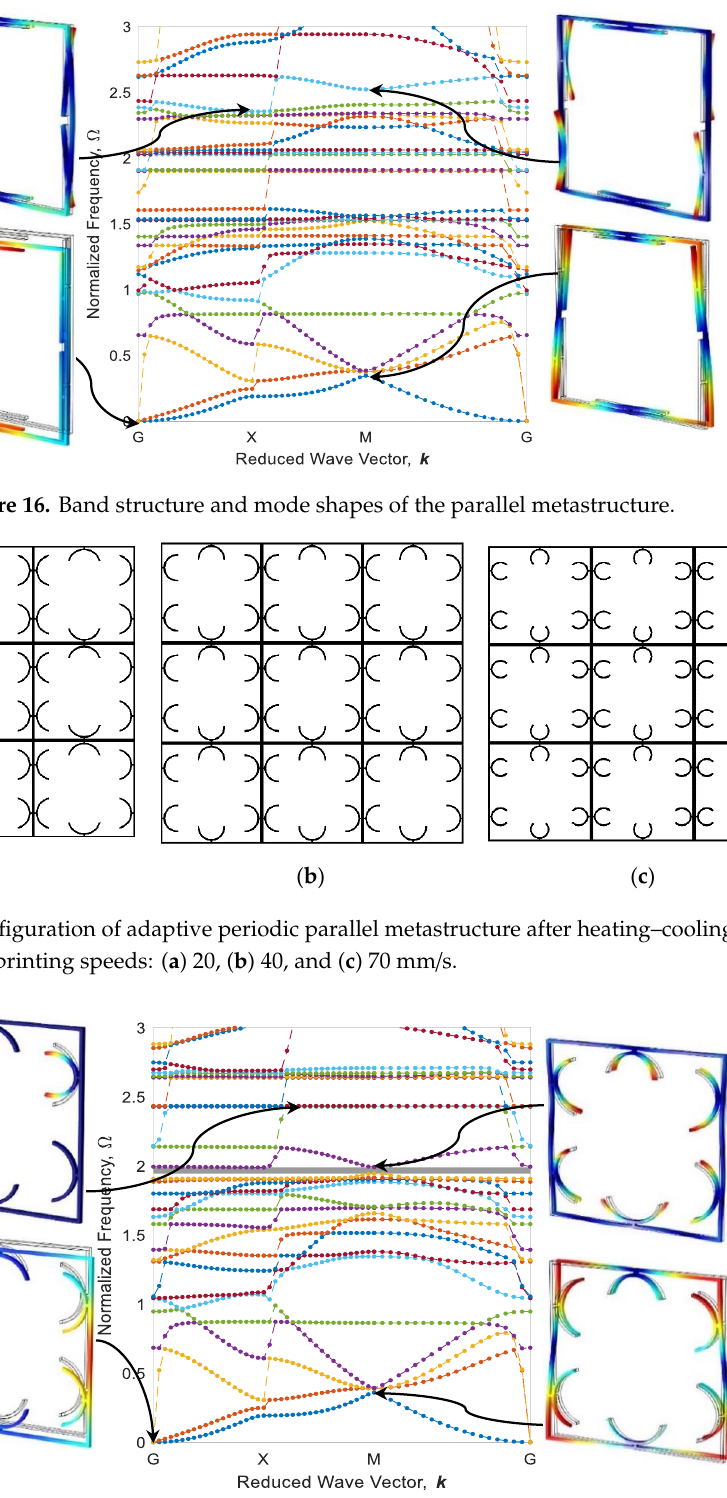
Figure 18. Band structure and mode shapes of the parallel metastructure with active elements printed at 20 mm/s after the heating – cooling process.